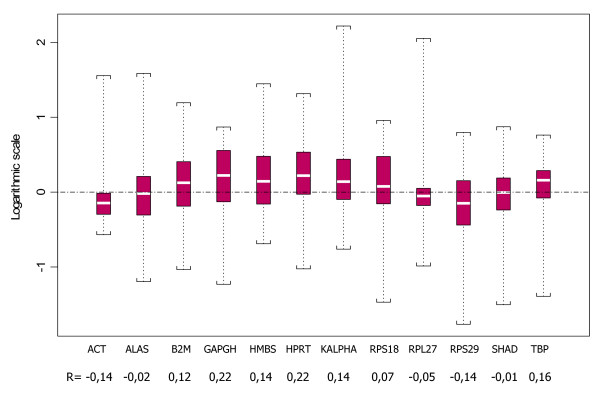
Expression ratio between HNSCC tissue and normal mucosa in the 12 reference genes. For estimation of the individual expression of each gene, the expression ratios of paired tissue specimens were calculated (R = HNSCC/normal). The log distribution of these ratios is represented for each gene by a box-plot. The central box represents the interquartile interval, the white line inside the box is the median value, and the extreme values represent the minimum and the maximum.